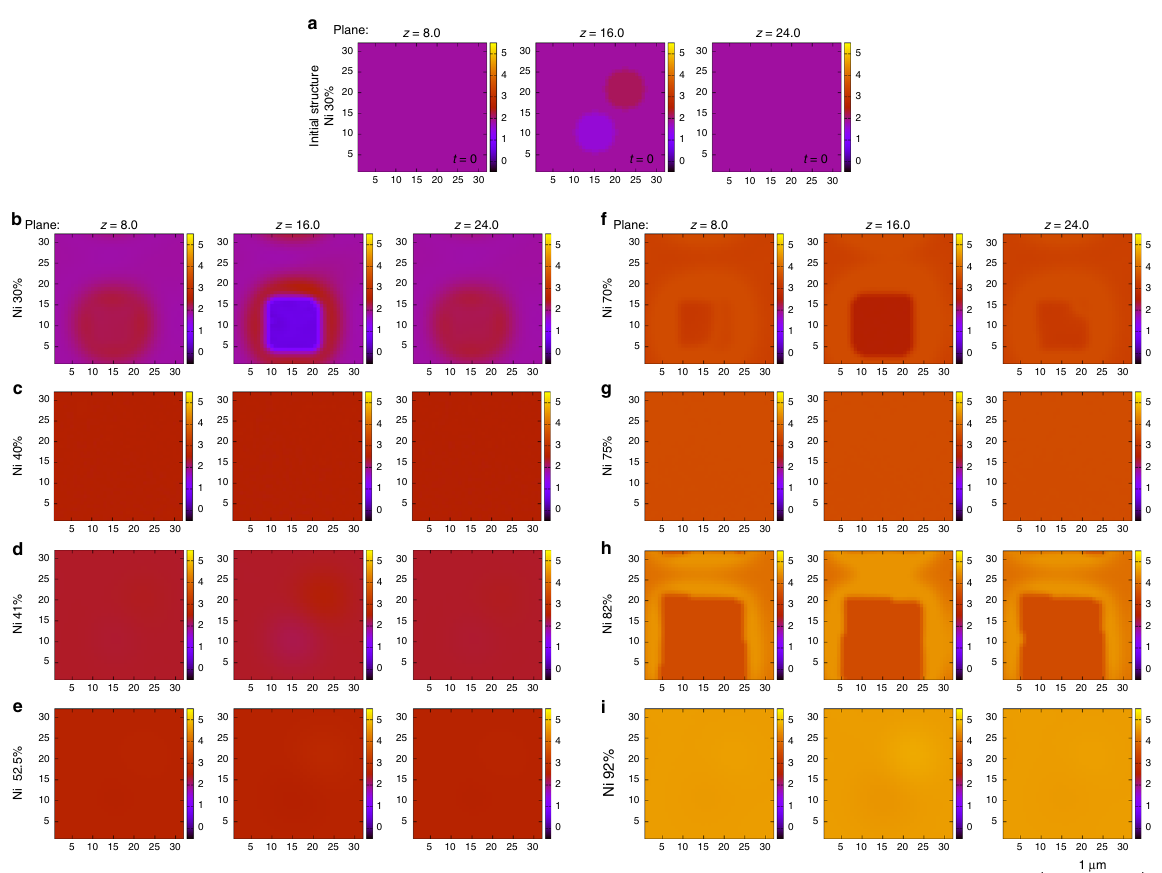
Fig. 7 3D simulations with (40 × 40 × 40) grid points and grid spacing of Δ x = 0.8. a Plot of initial microstructure ( φ Ni ) at planes z = 8.0, z = 16.0, and z = 24.0 for Ni 30%. Microstructures after a simulation step of 10 5 for Ni concentration, b 30%, c 40%, d 41%, e 52.5%, f 70%, g 75%, h 82%, and i 92% are plotted for φ Ni at cross-sections along the vertical planes, z = 8.0, z = 16.0, and z = 24.0. The length scale, given here is a guideline for the readers to have a rough estimation and obtained by comparing with the microstructures as in ref.